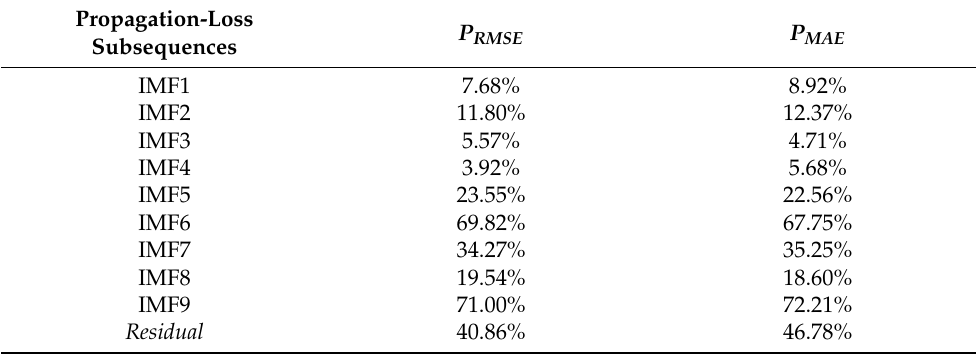
Table 10. Percentage improvement in propagation-loss subsequences prediction capability by GA (surface duct).